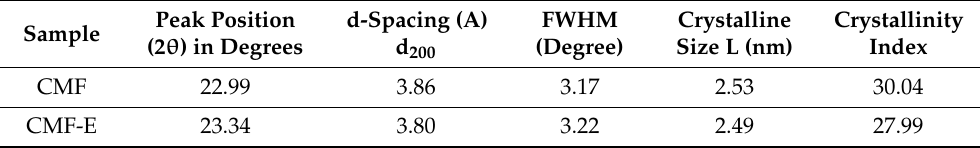
Figure 3. XRD patterns of the different samples. Table 3. XRD results of the cellulose microfiber (CMF) and CMF-E membrane.